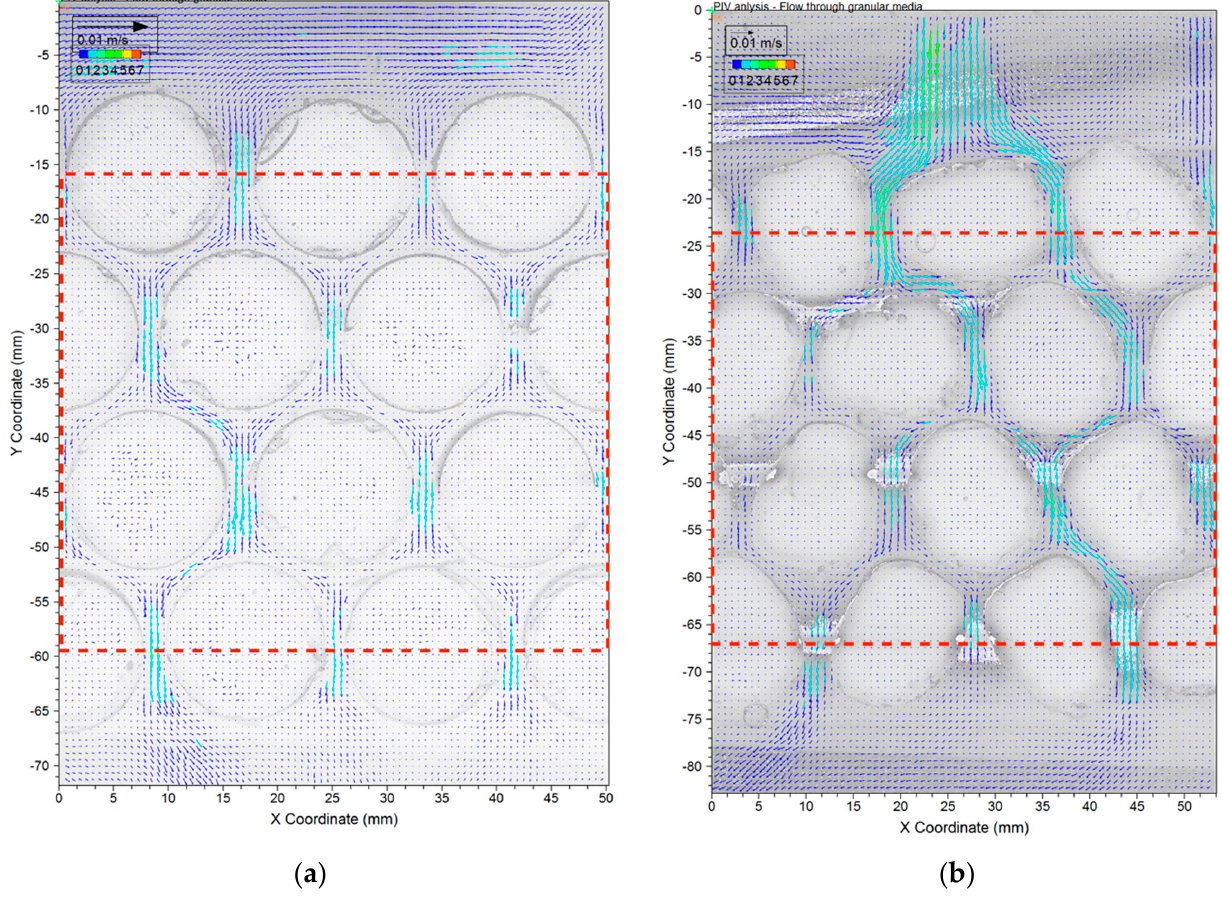
Figure 10. Flow images analyzed using Particle Image velocimetry (PIV) for ( a ) cylindrical particles and ( b ) simulated Ottawa sand.